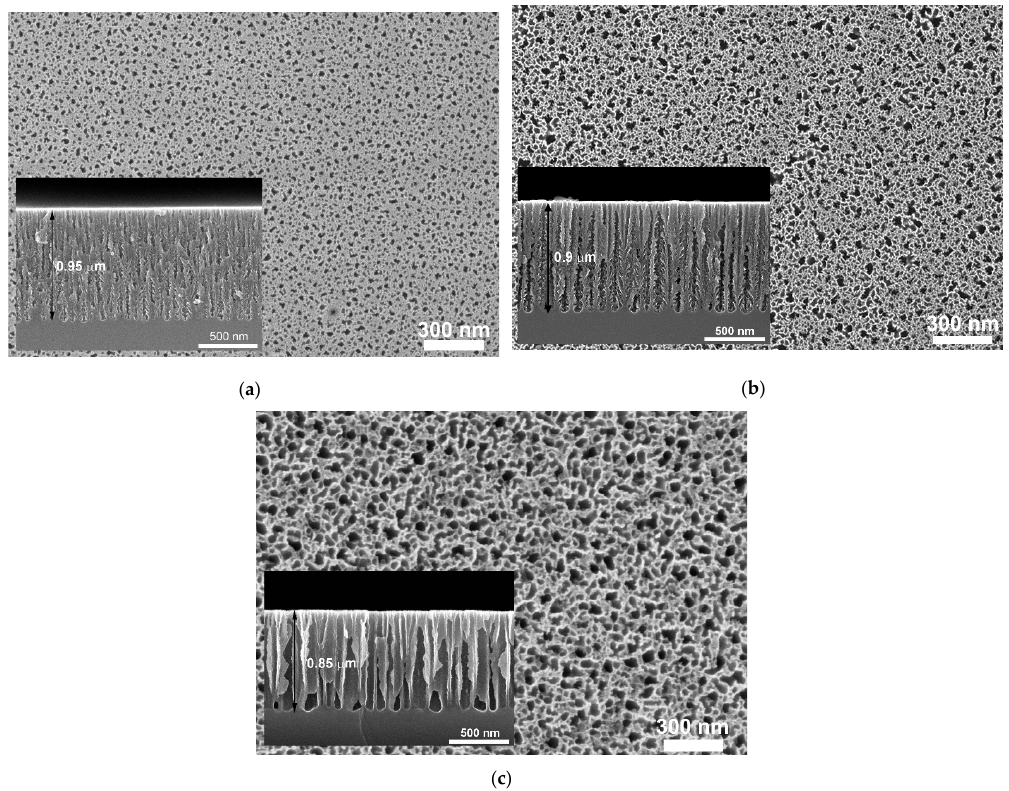
Figure 1. SEM images for a meso-PS sample after etching at a ( a ) 30 mA cm − 2 , ( b ) 60 mA cm − 2 , and ( c ) 100 mA cm − 2 current density. The top views are presented in the background, while the cross sections are in the insets.